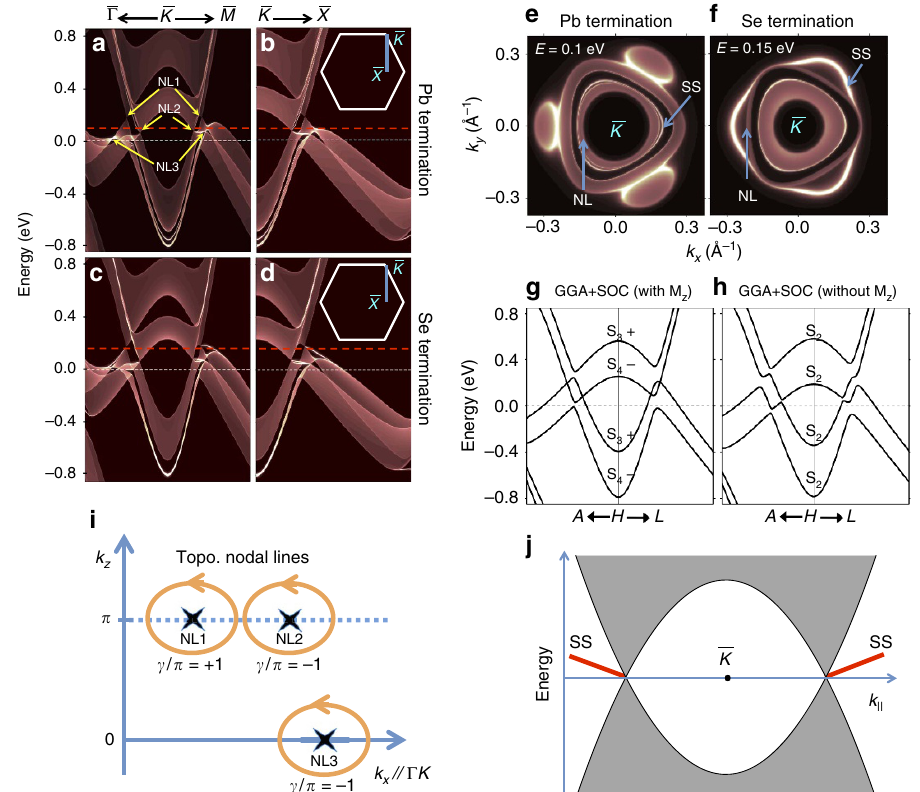
Figure 5 | Topological-nodal rings and associated surface states. ( a , b ) DFT project bulk bands and surface bands (bright white lines) of Pb-terminated (001) surface along (cid:2) G (cid:2) (cid:2) K (cid:2) (cid:2) M and a generic direction (cid:2) K (cid:2) (cid:2) X , respectively. ( c , d ) Same as a , b but of Se-terminated (001) surface. ( e , f ) The isoenergy contour showing the nodal-line states (NL) and surface states (SS). The energy is 0.10 and 0.15eV above the Fermi level for Pb- and Se termination, respectively, as indicated by the red dashed lines in a–d . ( g , h ) Bulk band structure of PbTaSe 2 with and without the reflection symmetry, respectively. In h , the reflection symmetry is broken by moving the Pb atom slightly in the vertical direction. ( i ) Schematic of the closed contours encircling the nodal lines for the calculation of the winding number. The arrows indicate the direction on the loops along which the Berry’s connection is integrated. ( j ) Schematic of a spectral cut passing (cid:2) K . The grey shaded region indicates the projected bulk band associated with a single nodal ring encircling (cid:2) K , and the red curves depict the surface states